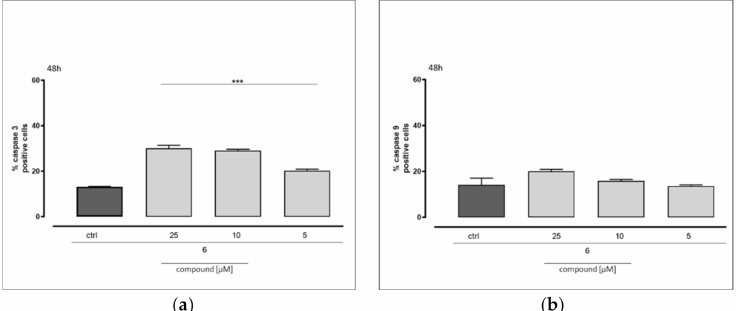
HeLa cells were treated with 6 (5-10-25 µ M) for 48 h. Results are expressed as mean ± S.E.M. from at least three independent experiments each performed in duplicate. Data were analyzed by Student’s t -test. *** p < 0.0001 vs.